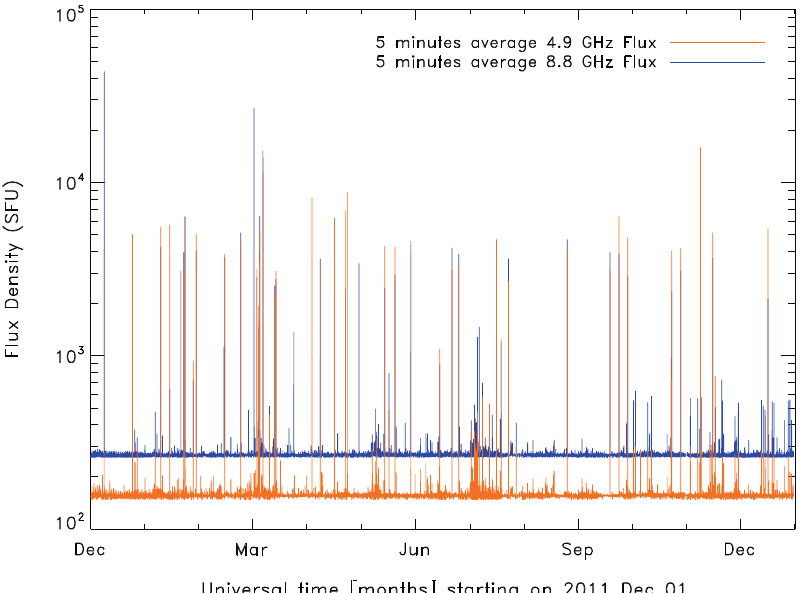
Fig. 4. The combined time history of the microwave flux density at two frequencies during the 13 months from 2011 December 01 to 2012 December 31, constructed from observations of the four RSTN stations. The flux density is averaged over 5 min, the background is removed for each instrument and an average backgound over the 13-month period is added.